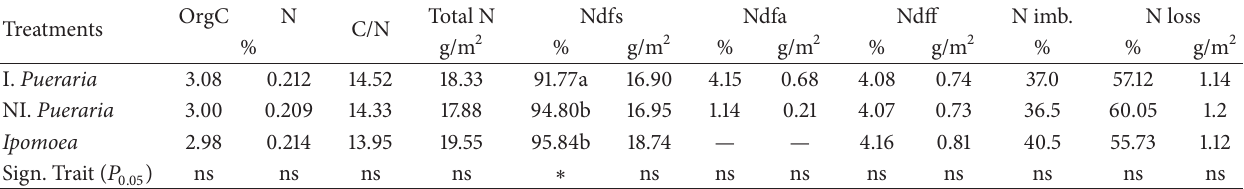
Table 4: Soil N status in inoculated and noninoculated Pueraria and Ipomoea plots at harvest.